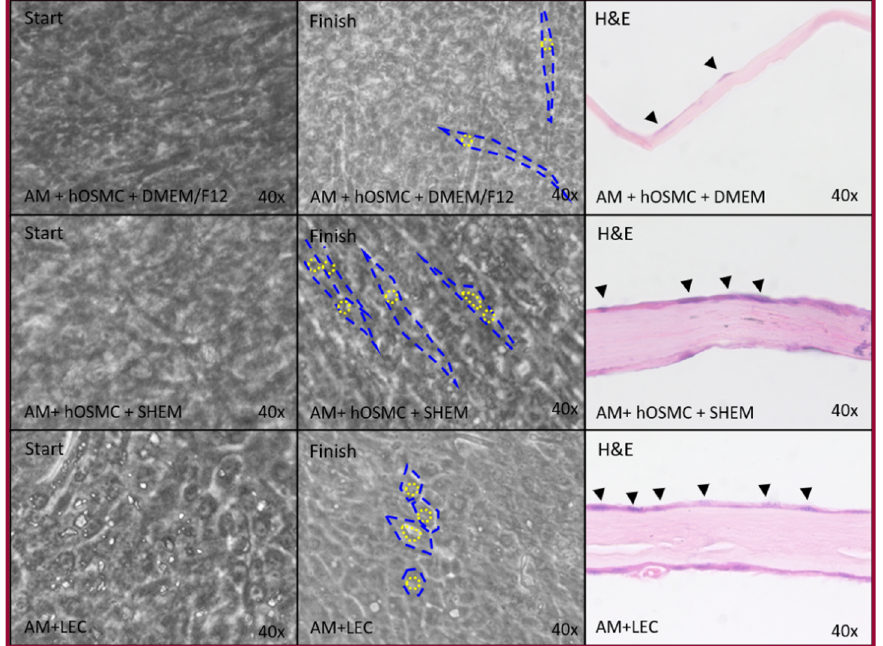
Figure 5. hOMSC epithelial differentiation. Comparison from the three conditions during the culture period and H&E staining yielded differences between groups. The culture with maintenance medium retained its fibroblast-like appearance with a prominent nucleus (black arrowhead) but almost no cytoplasm (AM + hOMSCs + DMEM/F12). The LEC line used as an epithelial control exhibited usual epithelial features—small, polygonal with a central nucleus and a 1:1 nucleus–cytoplasm ratio (AM + LEC). The experimental group displayed a fibroblast-like appearance with a prominent nucleus (black arrowhead); however, it was organized in palisades in the culture and showed an increase cytoplasm to nucleus ratio as observed in the H&E slides (AM + hOMSCs + SHEM). AM, amniotic membrane; hOMSCs, human oral mucosa stem cells; SHEM, supplemental hormonal epithelial medium; DMEM/F12, Dulbecco’s modified eagle medium/Ham’s